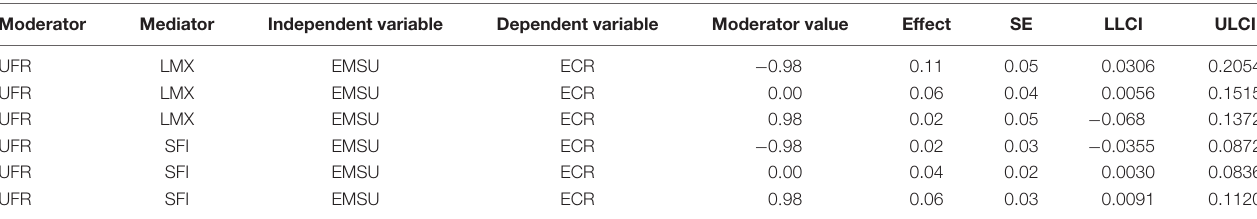
TABLE 3 | Conditional indirect effect of enterprise social media usage on employee creativity via LMX and SFI at level of enterprise social media usage